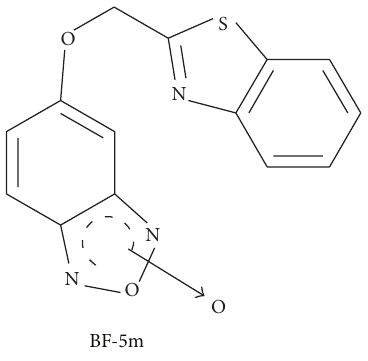
Figure 1: Chemical structure of the 5(6)-(Benzo[ d ]thiazol-2-ylme- thoxy)benzofuroxane derivative BF-5m. Aldose reductase IC 50 = 0.42 ± 0.01 𝜇 M in